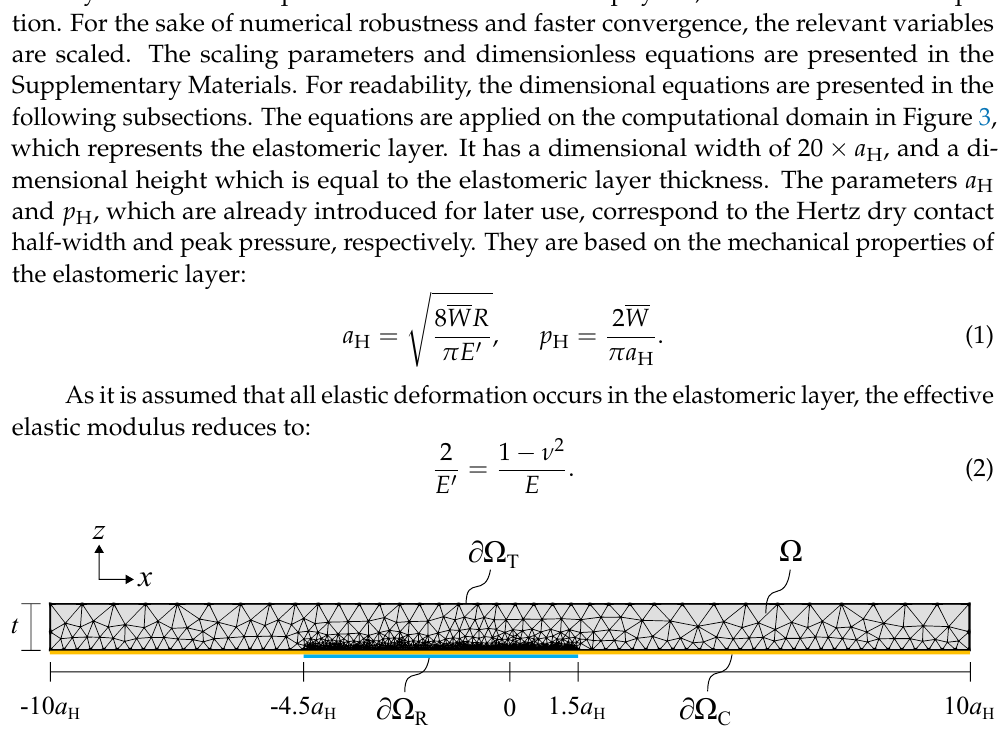
Figure 3. Computational domain and